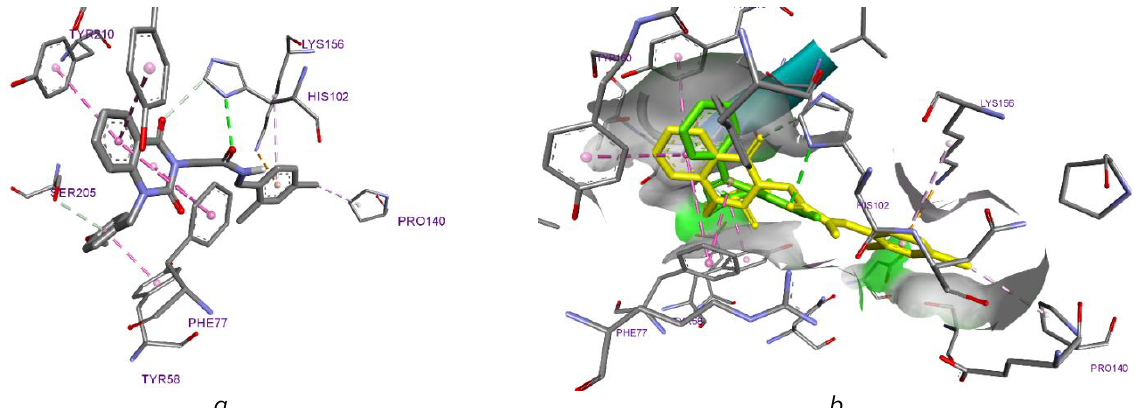
Fig. 6. a – interaction of 3.9 ligand with amino acids in BDZ-site of GABA receptor; b – compatible conformation of А diazepam (green) and 3.9 ligand